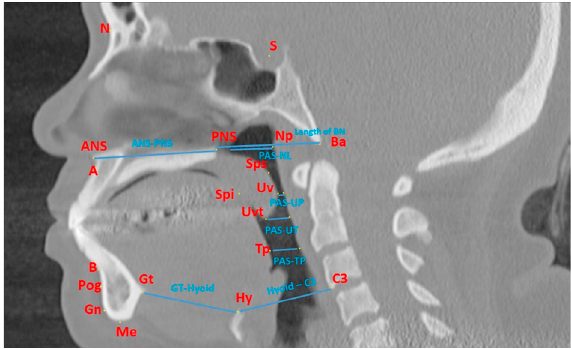
Figure 1. Quick Ceph Studio, San Diego, CA. Cephalometric landmarks and reference lines (mm). S (sella), centre of sella turcica; N (nasion), V notch of frontal and nasal bones; A point, deepest point between ANS and upper incisor alveolus; B point, deepest point between pogonion and lower incisor alveolus; Ba (basion), most inferior point of occipital bone; ANS, tip of anterior nasal spine; PNS, tip of posterior nasal spine; Pog (Pogonion), most anterior point of symphysis; Me (menton), most inferior point of symphyseal outline; Gn (gnathion), most anterior and inferior point on bony chin; Gt (genial), most posterior point of genial tubercle; Hy (hyoid body), most antero superior point of the hyoid bone; Uvt (Uvula tip), most posterior inferior point of the uvula; Uv (Uvula), most posterior point of uvula; PAS (pharyngeal airway space); NL (nasal line); PAS-UP, minimal PAS between uvula and posterior pharyngeal wall; PAS-UT, minimal PAS between uvula tip and posterior pharyngeal wall; PAS-TP, minimal pharyngeal airway space between back of tongue and posterior pharyngeal wall; ANS-PNS, distance from ANS to PNS; Length of BN, PNS to basion; Hyoid-C3, distance between C3 (anterior and inferiorly) and hyoid (antero-superiorly); GT-hyoid, genial tubercle to hyoid distance; Length SP, distance from PNS to tip of uvula (midline); SP thick, maximum thickness of soft palate measured perpendicular to PNS to uvula line.